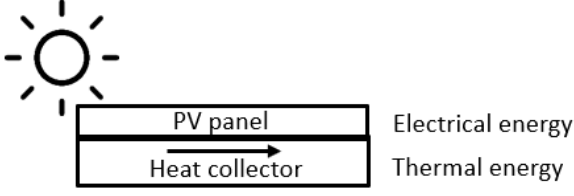
Figure 4. Basic concept of PV/T system.